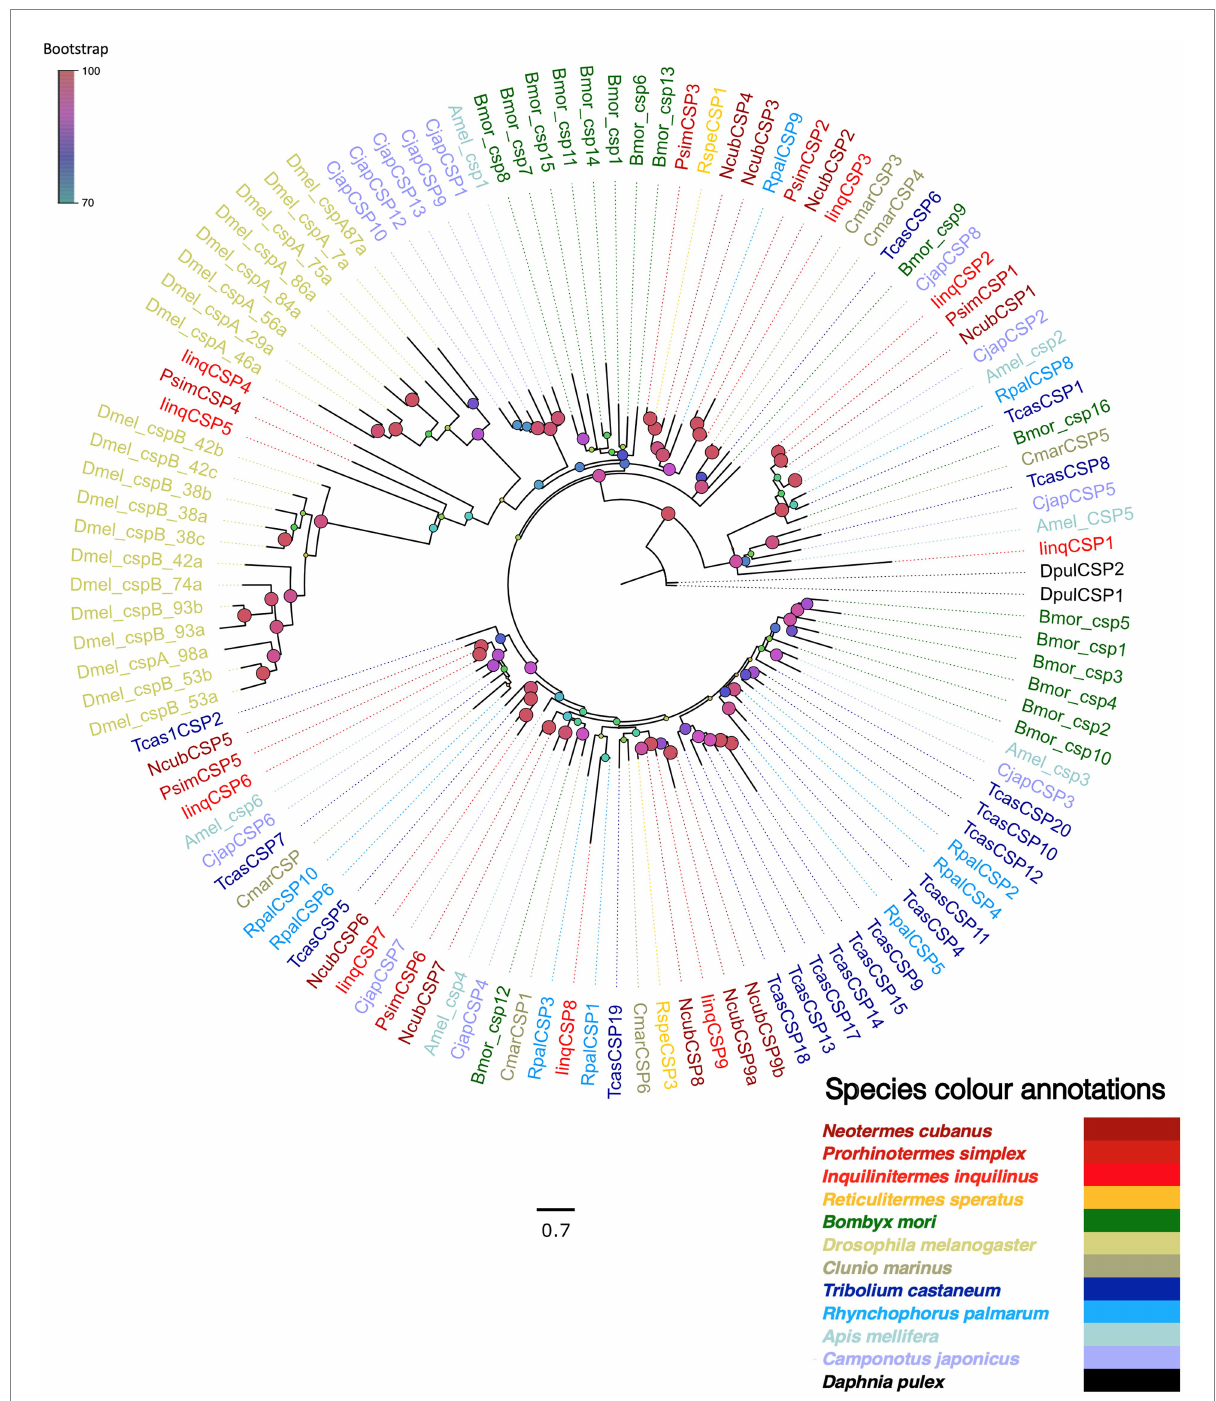
FIGURE 6 Maximum likelihood phylogeny of termite CSPs. The tree was constructed using LG + R as amino acid substitution model and rooted with D. pulex CSP sequences (Dpul, black) as outgroup. The newly identified termites CSPs were named as N. cubanus (Ncub), Psim: P. simplex (Psim), I. inquilinus (Iinq). The other species included were R. speratus (Rspe), T. castaneum (Tcas), R. palmarum (Rpal), B. mori (Bmor), A. mellifera (Amel), D. melanogaster (Dmel), C. marinus (Cmar), and C. japonicus (Cjap). Sequence names are colored according to species and color codes are provided in the in-figure legend. The node colors represent bootstrap support with 1,000 replicates and the scale bar represents estimated amino acid substitutions per site.